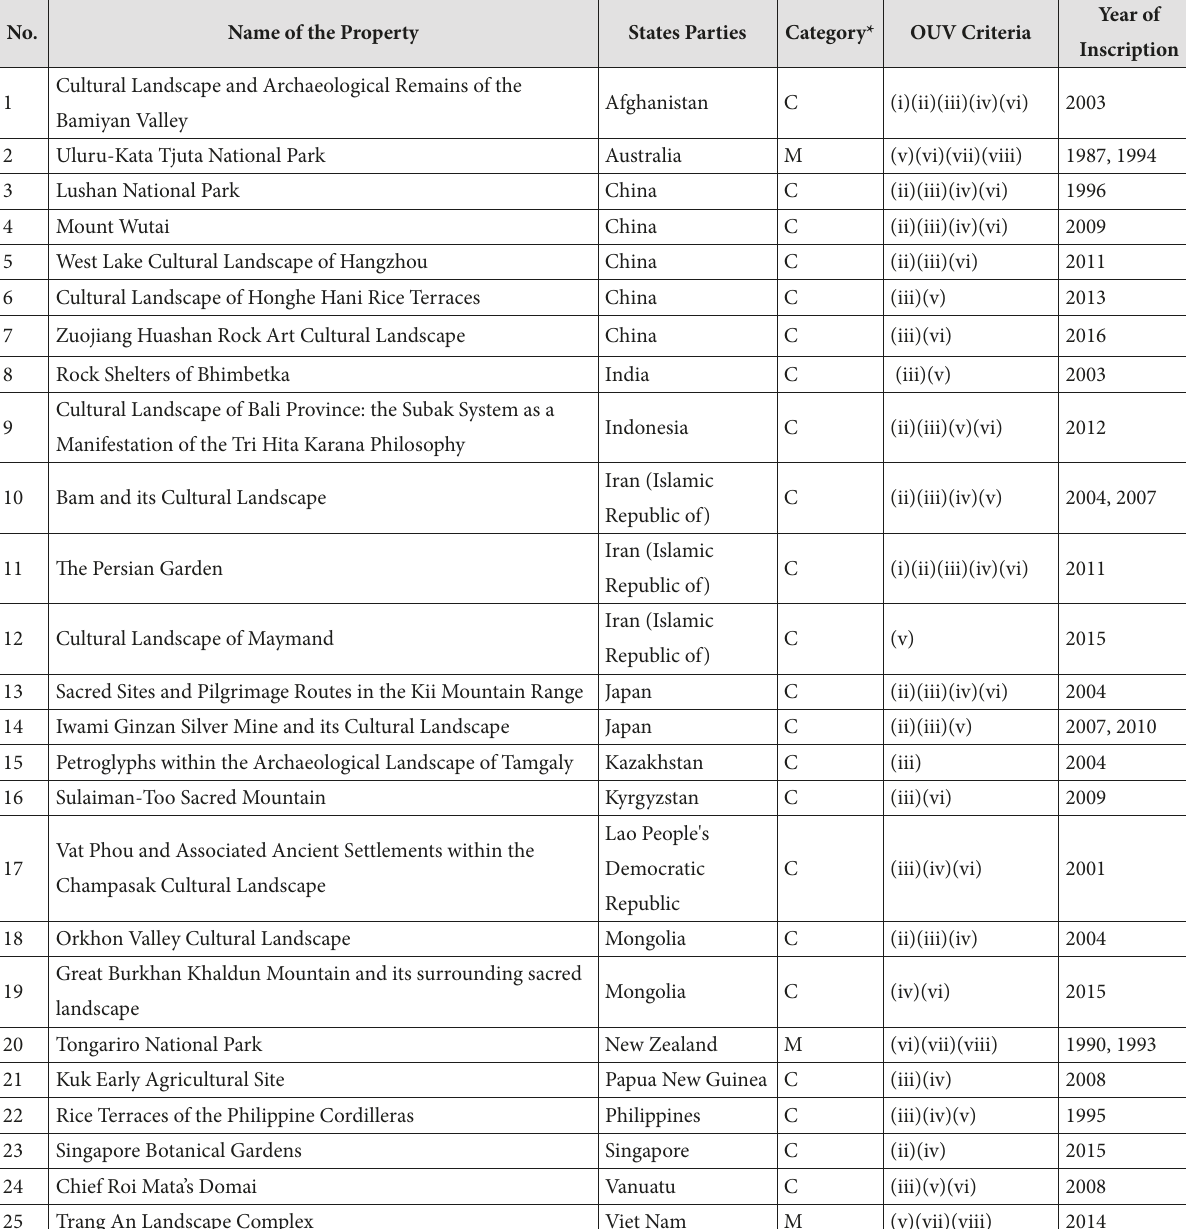
Table 4 List of the World Heritage Cultural Landscape in Asia and the Pacific (Source: